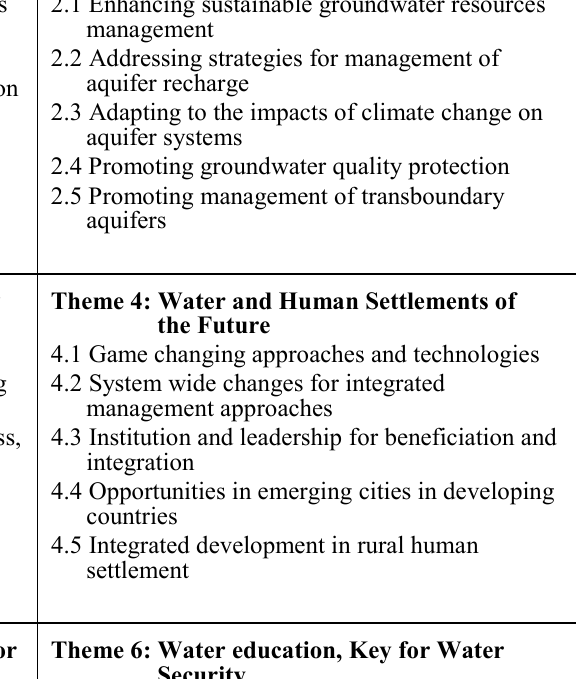
Table 1 Focal areas of IHP-VIII 4 Water Security − Responses to Local, Regional and Global Challenges. Theme 1: Water-related Disasters and Hydrological